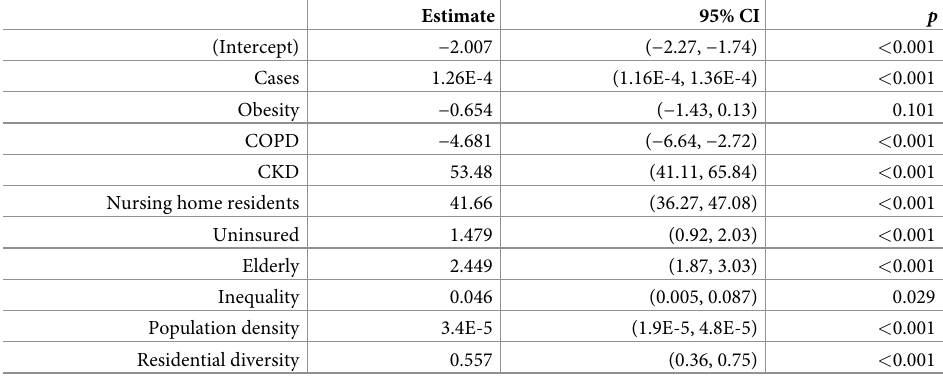
Table 2. Results of multivariate analysis with linear model, adjusting for case rate.